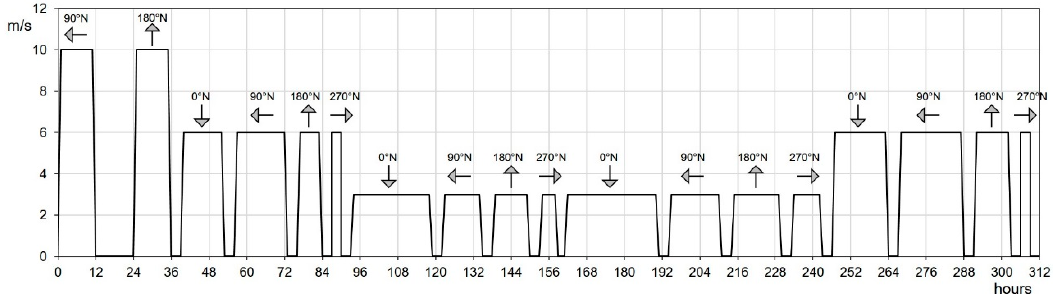
Figure 8. Sequence of winds used in the simulation to represent hydrodynamic forces acting in the lagoon over an average year. The arrows indicate the directions from which the wind blows.